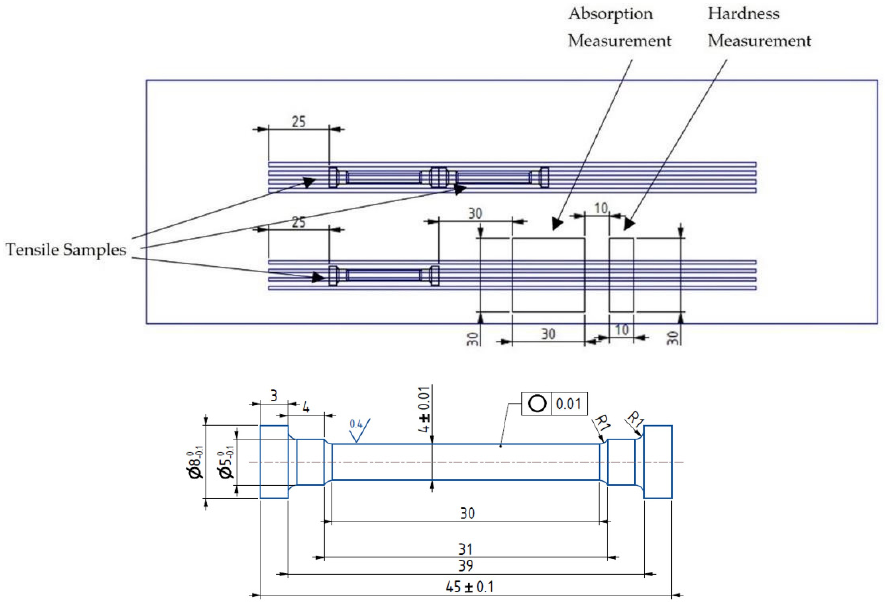
Figure 3. Position of samples used for experiments and detail of tensile specimens.